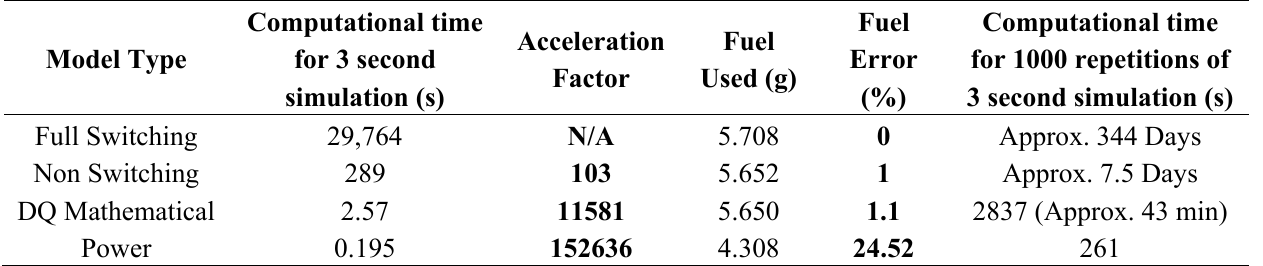
Table 2. Comparison of computation